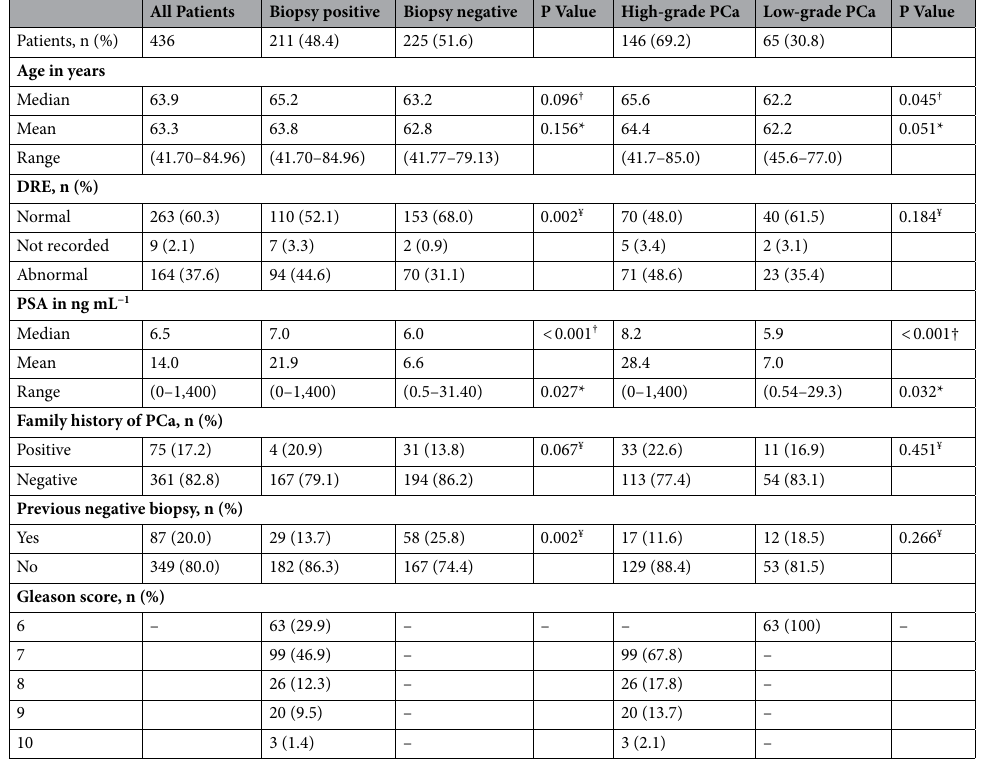
Table 1. Clinical Features of the Patient Cohort. *Student’s T-test. ¥ Pearson’s chi squared test. † Wilcoxon Rank